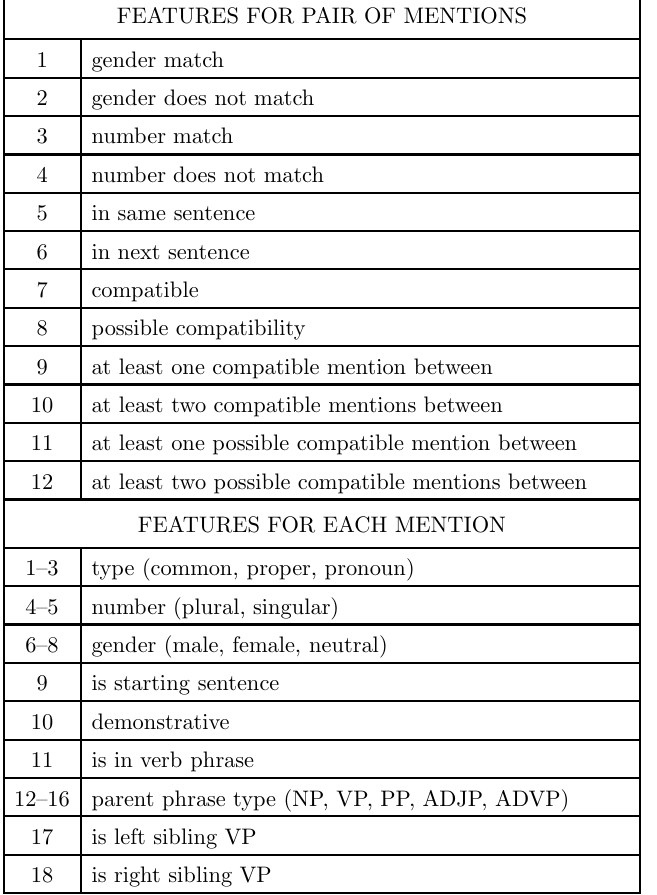
Table 1. Coreference candidate binary features FEATURES FOR PAIR OF